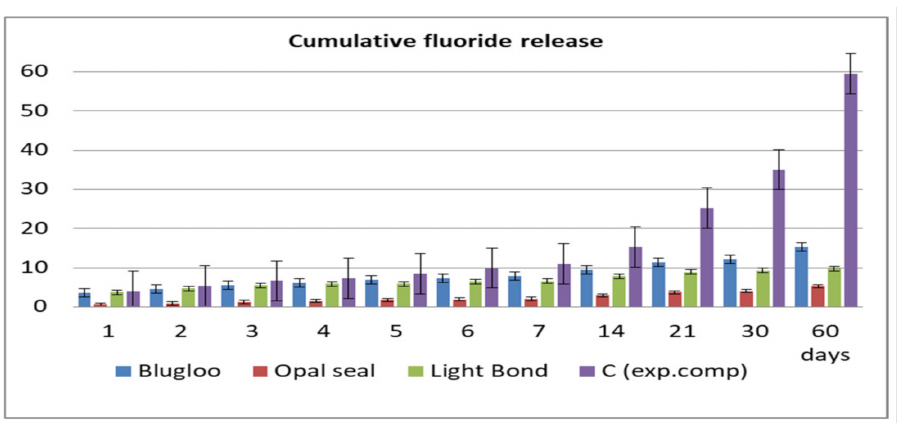
Figure 3. Cumulative fluoride release of the four